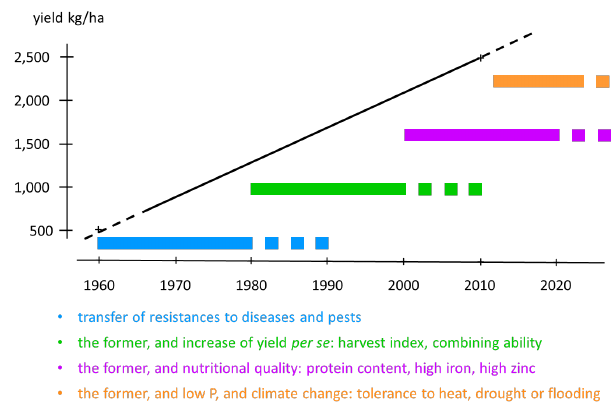
Figure 1. Evolution of the breeding strategy in bush common bean in the tropics over the last decades.